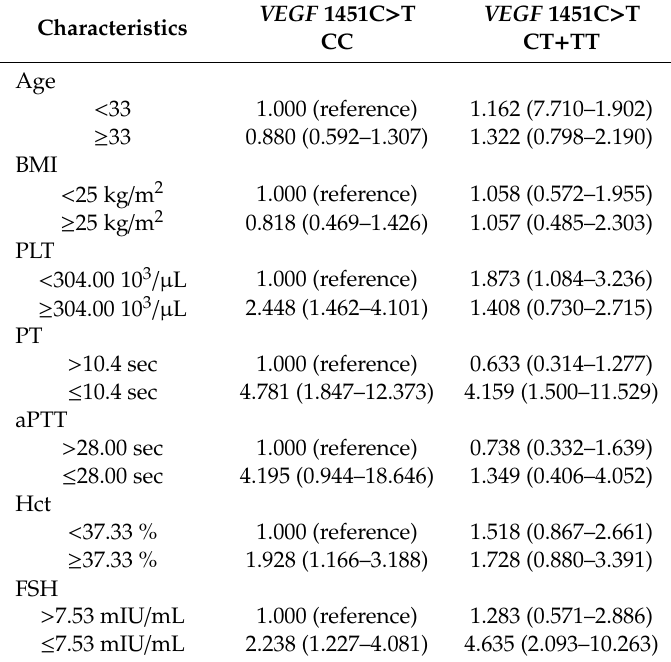
Table 5. RPL incidence by interactions with environmental factor such as advanced age, BMI, PLT, PT, aPTT, Hct,